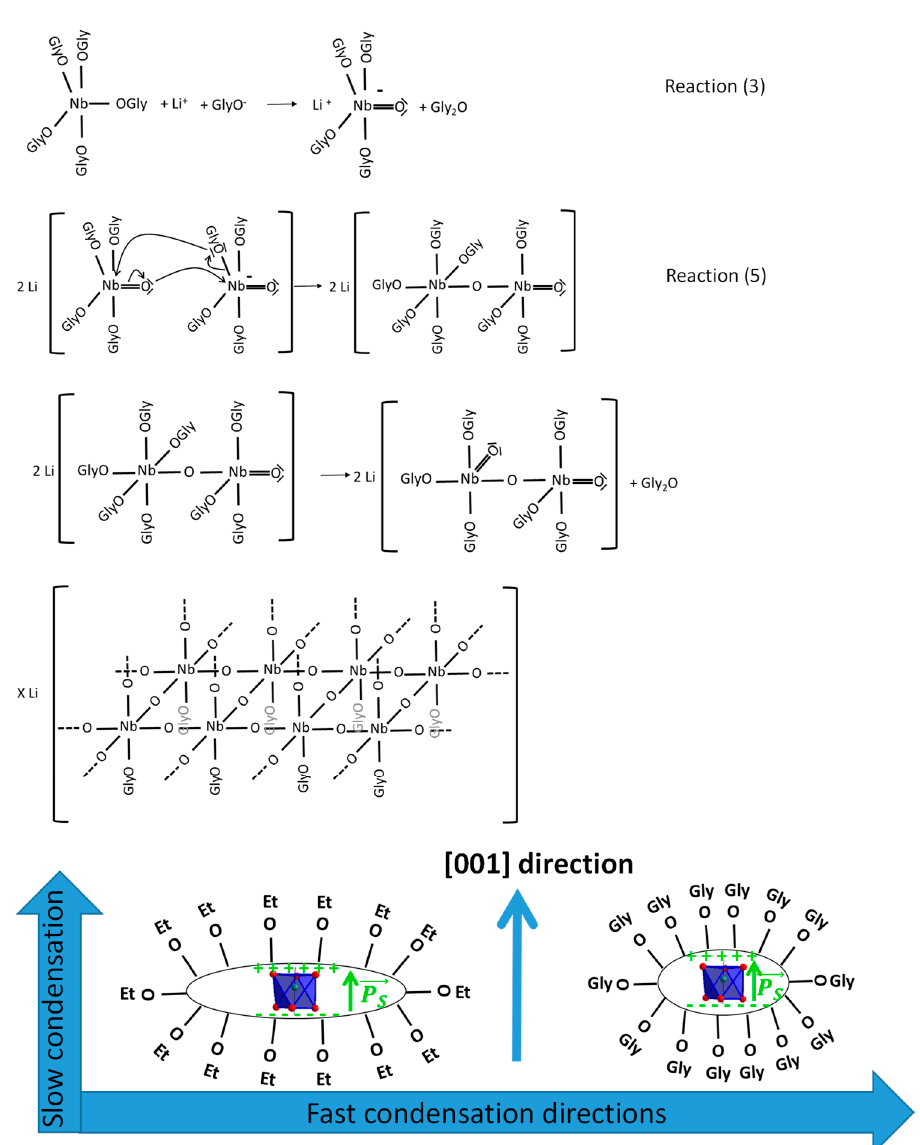
Figure 4. Scheme of the reaction pathway leading to LiNbO 3 nanocrystals with different shape anisotropy. GlyO and EtO are glycoxy and ethoxy groups corresponding to − OC 4 H 8 OH and − OC 2 H 5 , respectively. The reactions (3) and (5) and the subsequent condensation reactions are described in the text. An oxygen octahedra (in blue) surrounding Nb 5+ ions is also illustrated in the lower panel together with the spontaneous polarization Ps (green arrow) pointing towards the [001] direction.